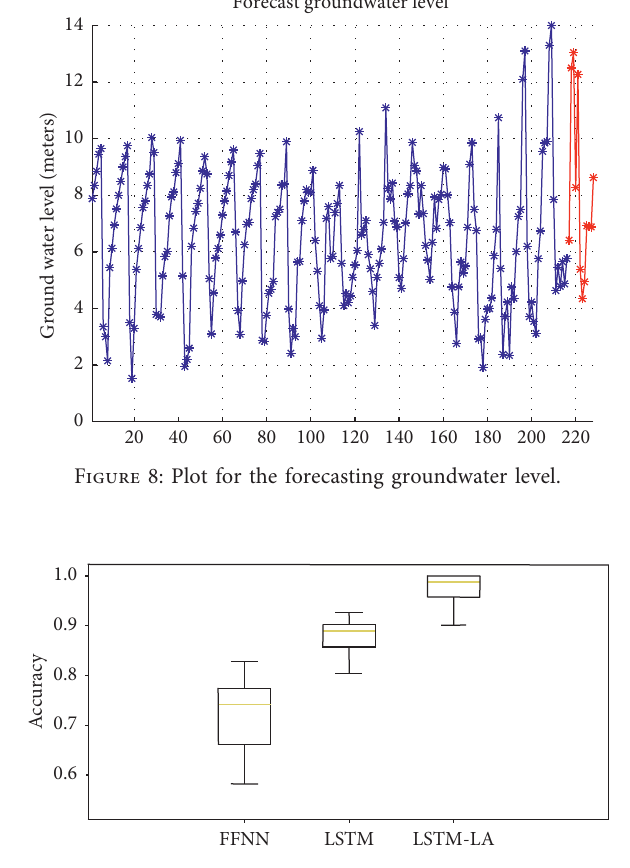
Figure 9: Box and whisker plot comparing the prediction accuracy of the models.